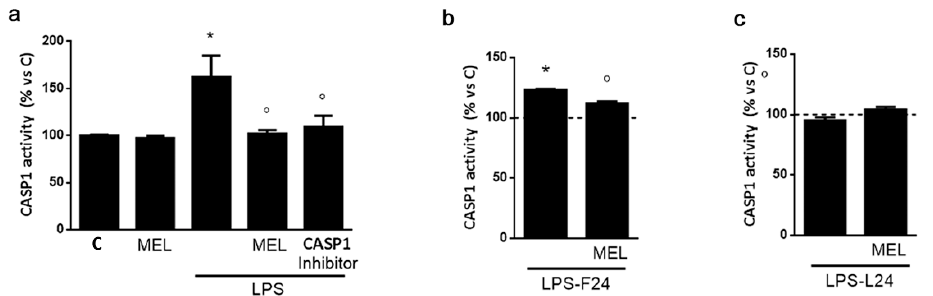
Figure 6. Caspase 1 (CASP1) activity assay in HMC3 microglia. Activation of CASP1 was assessed by incubation with the fluorogenic substrate Ac-VAD-AFC. In ( a ), LPS (1 µ g/mL), MEL (1 µ M) and CASP1 inhibitor (10 µ M) were added for 48 h. In ( b ), MEL (1 µ M) was added for 48 h alone or in combination with LPS (1 µ g/mL), which was present only during the first 24 h, followed by removal and further incubation for 24 h (LPS-F24). In ( c ), MEL (1 µ M) was added for 48 h alone or in combination with LPS (1 µ g/mL), which was added to the cells only during the last 24 h (LPS-L24). In ( b , c ), dotted lines indicate control untreated condition (C). Data are mean ± SEM of 3 independent experiments. * p < 0.05 vs. C and ◦ p < 0.05 vs. respective LPS by one-way ANOVA followed by Fisher’s LSD post hoc test for